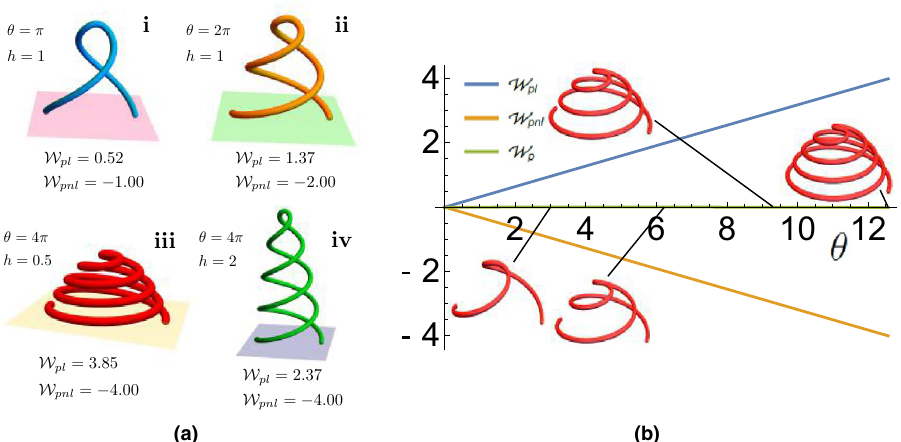
Figure 2. Twisted paraboloids used to highlight aspects of the polar writhe. ( a ) paraboloids with varying heights h and winding angles θ . ( a )(i),(ii) paraboloids with equal height but different winding exhibit differences in both W pl and W pnl as a result of large-scale rotation and increased helical density. ( a )(iii),(iv) paraboloids with equal winding but varying height exhibit differences in W pl only as the extent of buckling remains constant while helical density is varied. ( b ) The polar writhe decomposition as a function of the winding angle θ for a parabola for which W p = 0